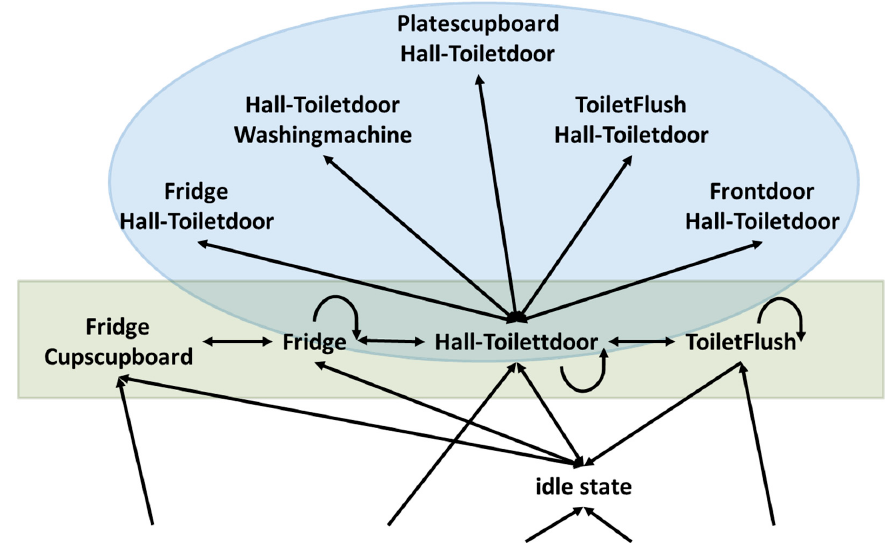
Figure 1. The part of the learned Markov Model (MM) showing an example (green rectangle) of two nested Activity of Daily Living (ADL): drinking and use toilet. A typical MM-structure: a star is seen in the blue rounded area.